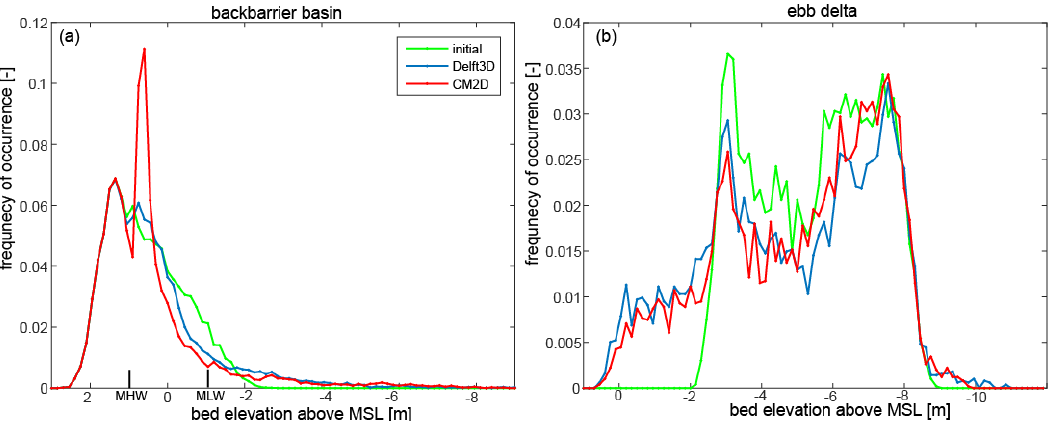
Figure 6. Comparison of hypsometry in the backbarrier basin ( a ) and in the ebb delta ( b ) at year 500 (Figure 5e,j).